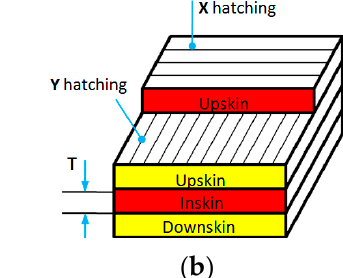
Figure 3. Geometrical aspects of laser spot and building layers. ( a ) laser trajectories and overlapping of the focal spot; ( b ) scanning strategies and layer types.